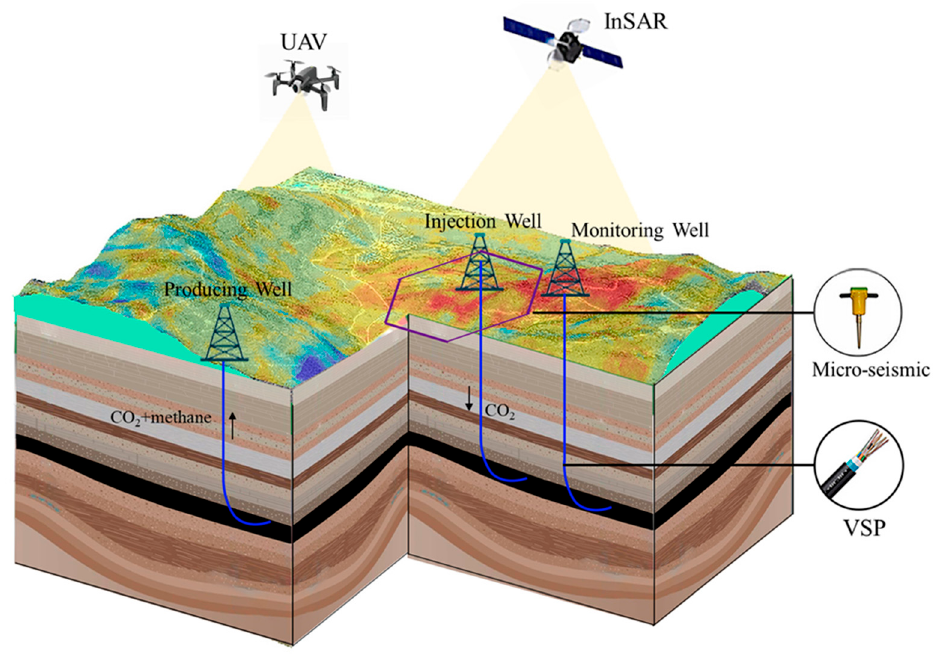
Figure 11. Schematic diagram of multi-method monitoring at the CCUS project.